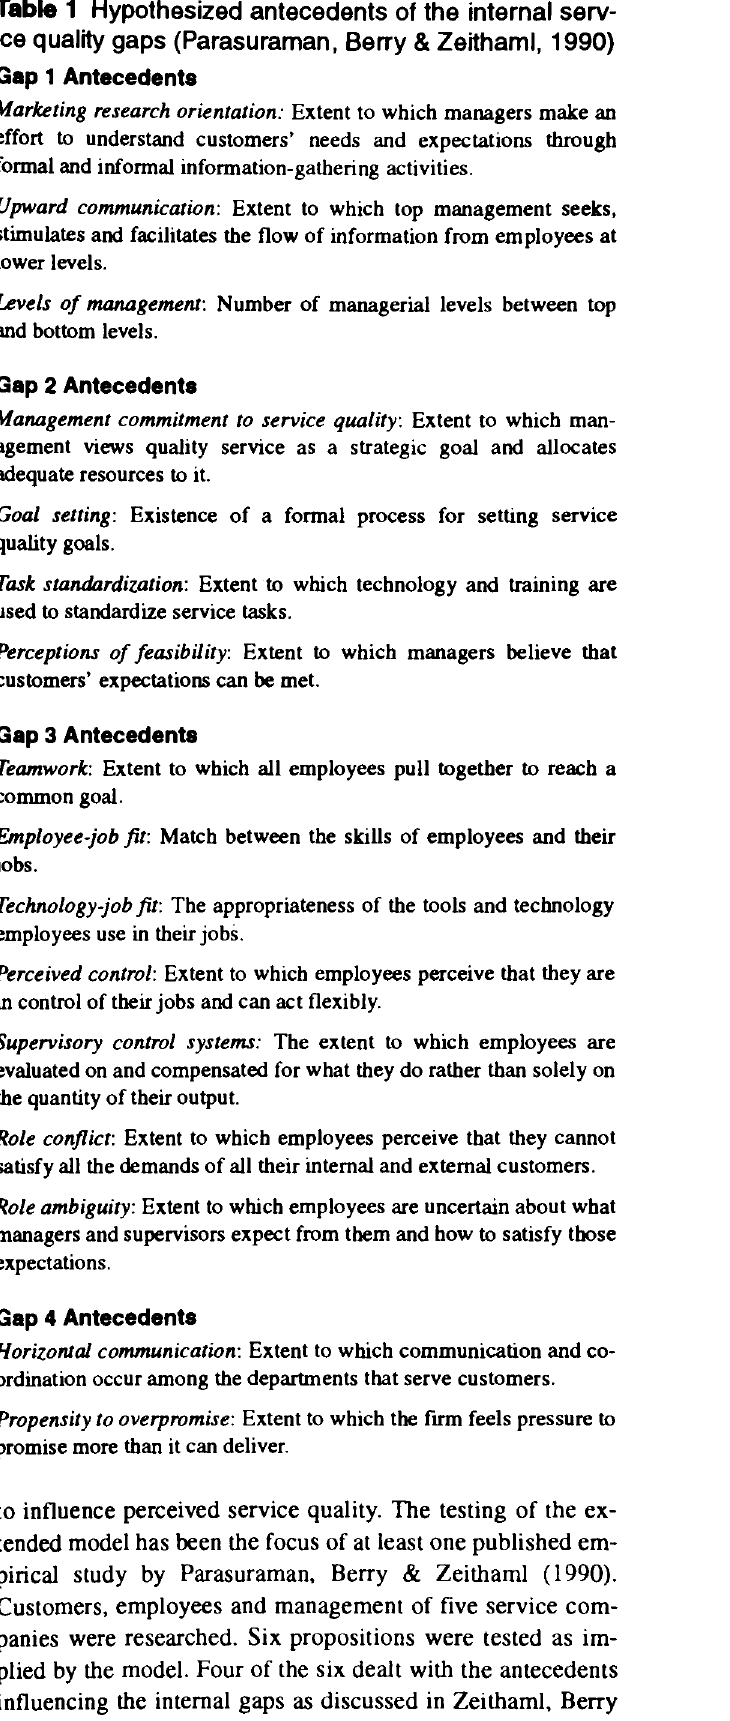
Table 1 Hypothesized antecedents of the internal serv ice quality gaps (Parasuraman, Berry & Zeithaml, 1990) Gap 1